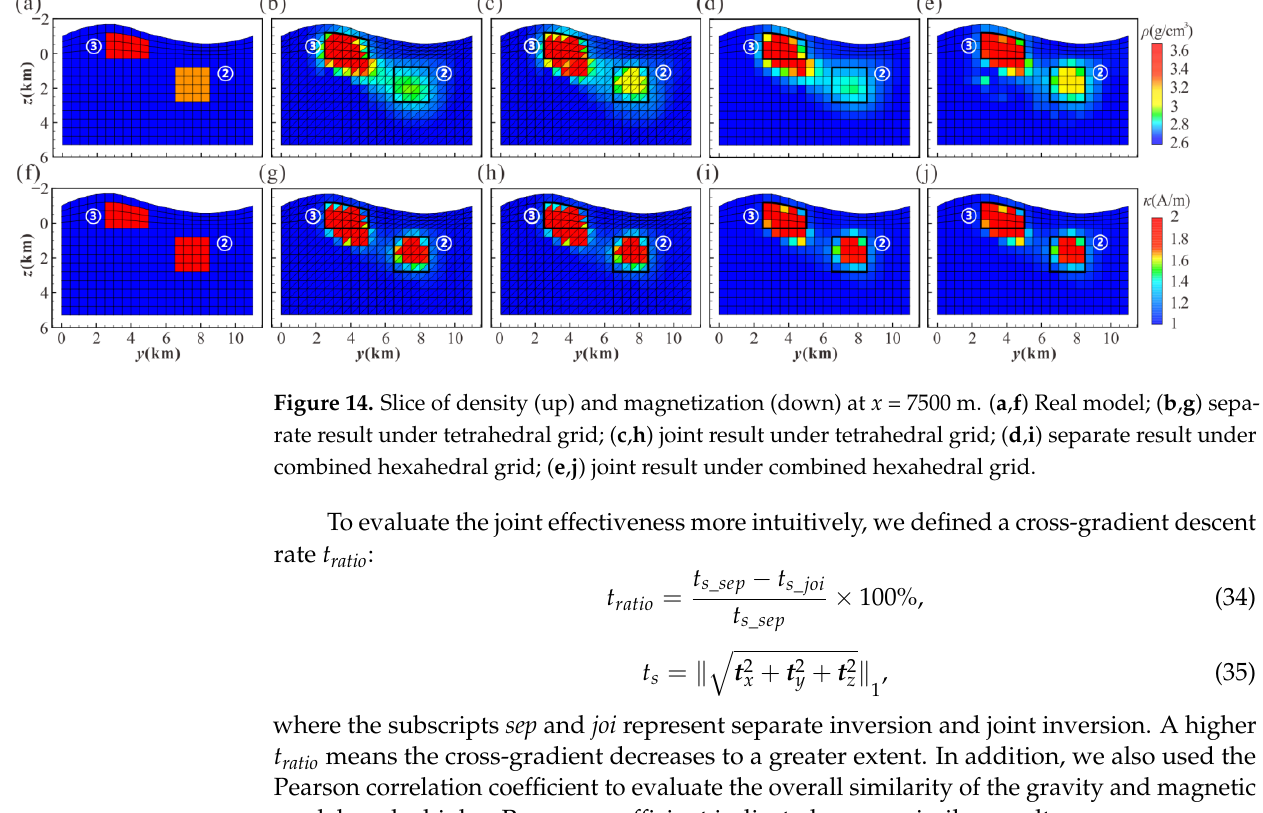
Figure 15. Cross-gradient descent rate of joint inversion under different Λ j 0 ρ . Table 3. RMSm of inversion results.